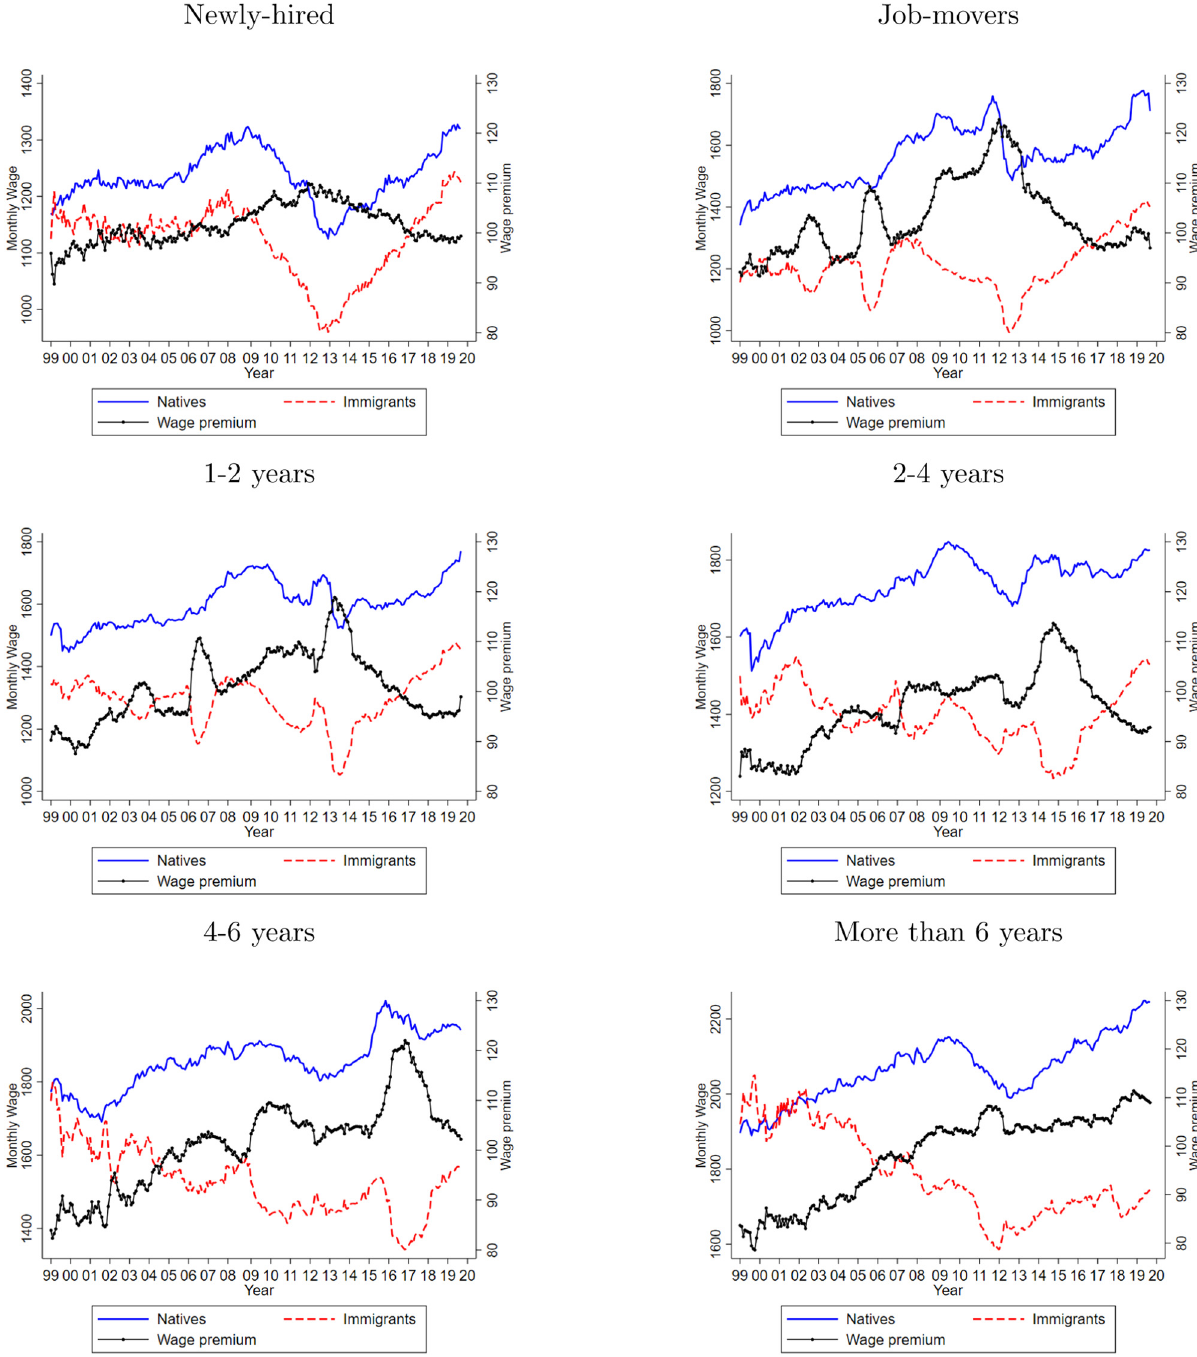
Figure A11: Monthly average wage by nationality and tenure. Note: The wage premium is computed as ( ) / w w ¯ ¯ − 1 N t M t , , , where w ¯ j t , is the monthly average wage for natives = j N and immigrants = j M at month t . Wage premium is normalised to 100 at Q 2008 1 . Wages are seasonally adjusted by taking out the coe ffi cient of the monthly dummies from an OLS regression. Source: